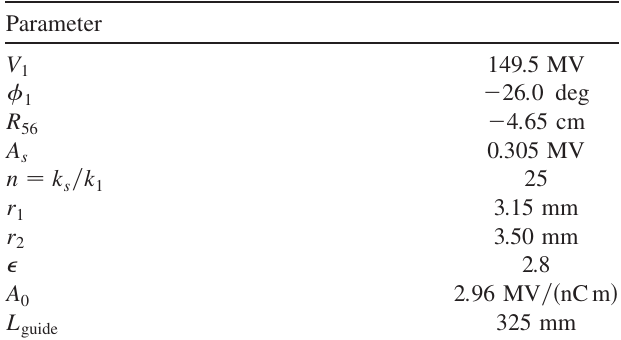
FIG. 8. (Color) Bunch current distributions after the chicane for different bunch length variations at the injector (left plot) and for different relative bunch charge variations (right TABLE III. The rf and bunch compression parameters for the second-order compensation with the passive linearizer ( C ¼ 6 ).